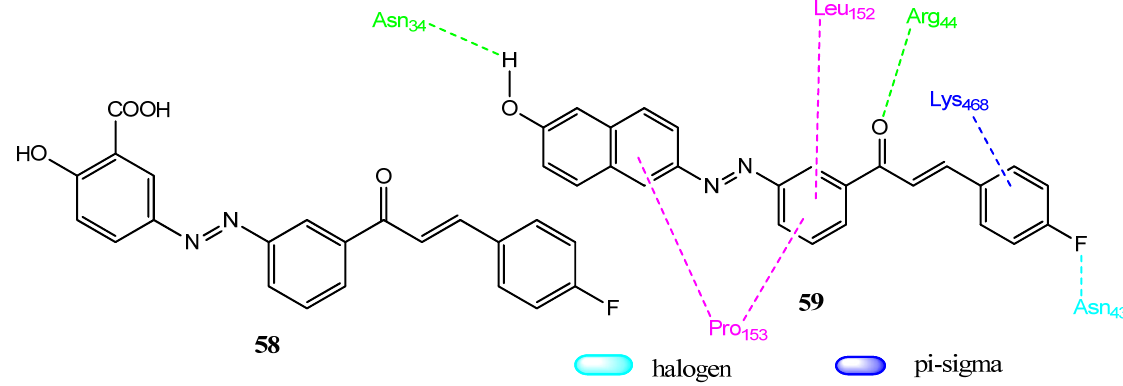
Figure 12. Chalcone–derived compounds.